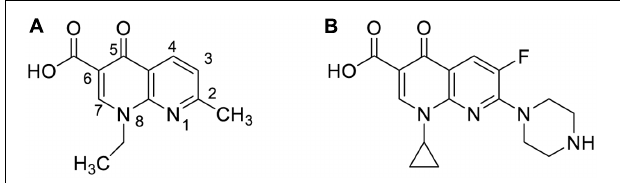
FIGURE 1 | Chemical structures of nalidixic acid (A) and ciprofloxacin (B) .